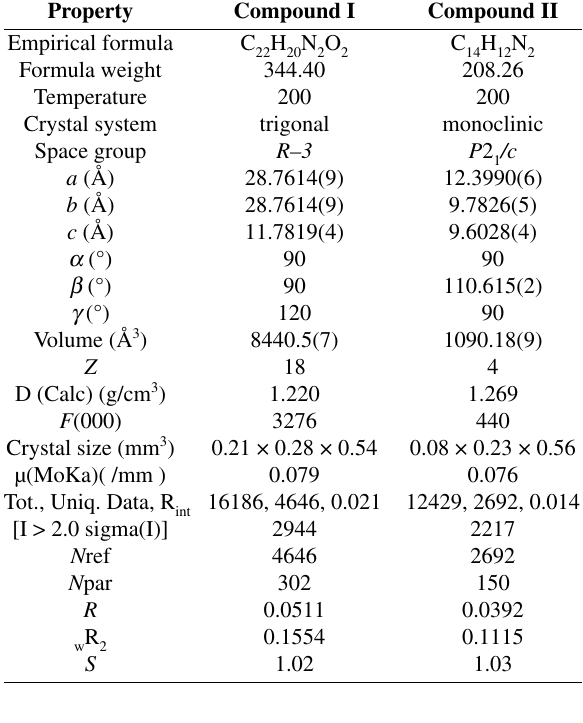
Table 1 Crystallographic data and structure refinement summary for compounds I and II Property